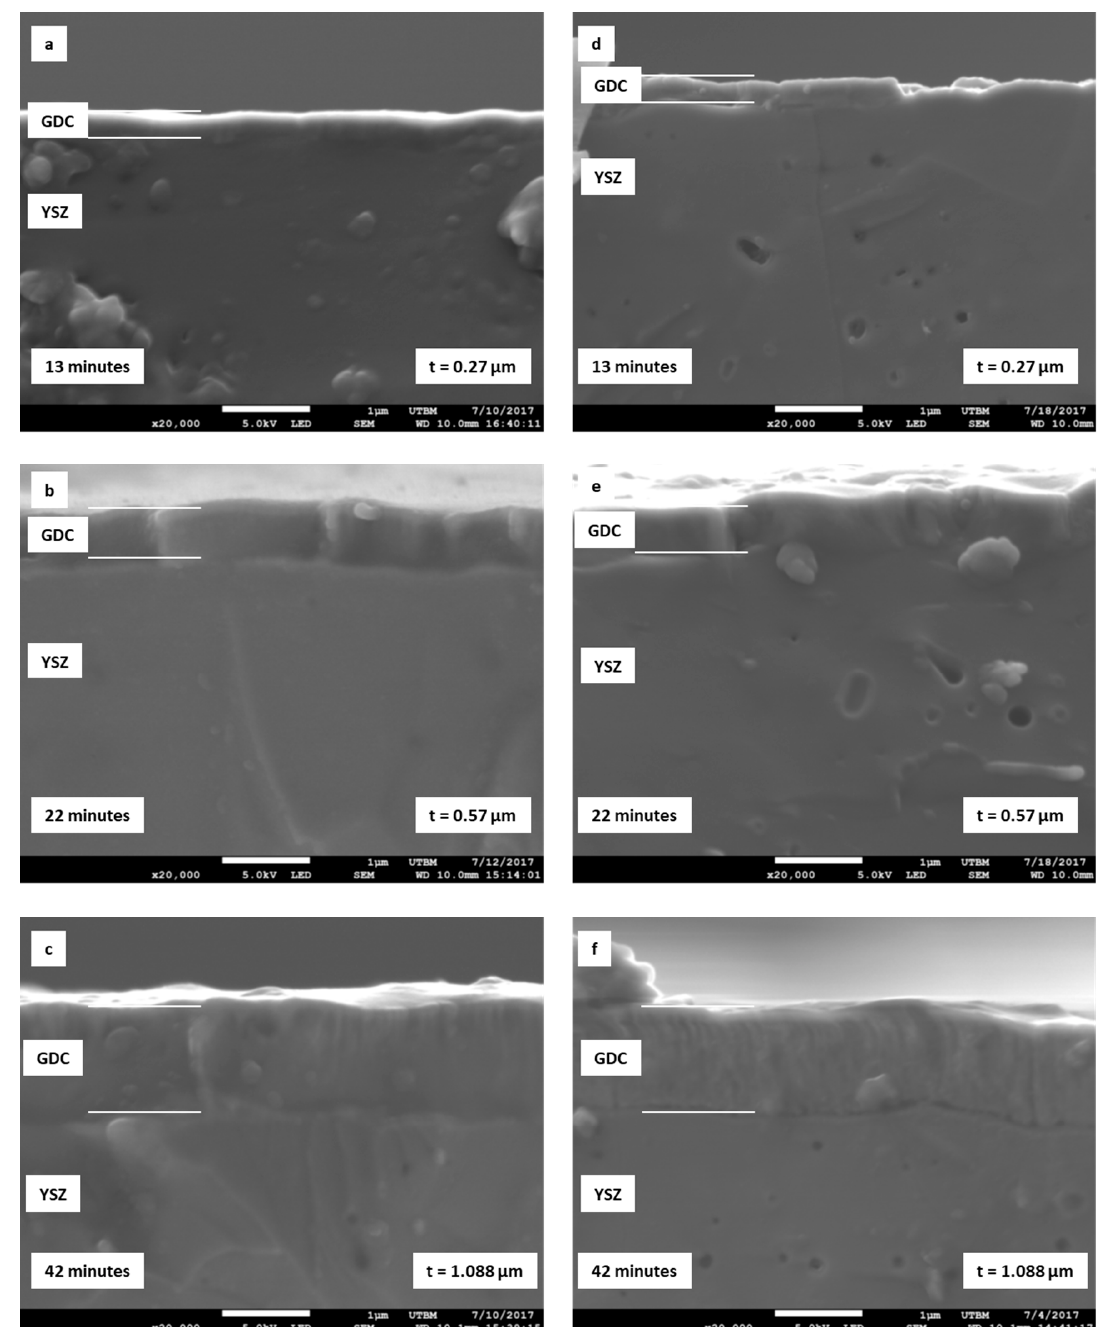
Figure 4. SEM micrographs of GDC coating synthesized under 0.1 Pa as a function of different thickness. ( a–c ) As deposited; ( d–f ) after annealing treatment under static air for two hours at 1000 °C).